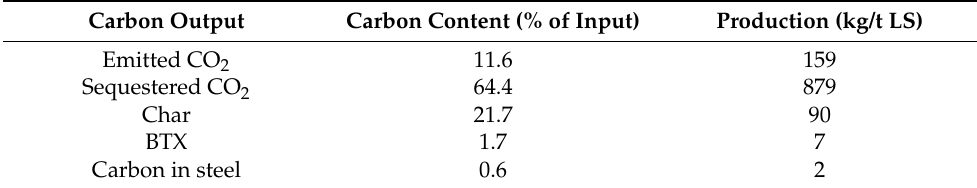
Table 8. Distribution of carbon in the outputs of the process, in terms of the fraction of the total carbon input, which accounts for the carbon in the biomass, the scrubbing agent (RME in the calcu- lations), and the CO 2 from the flux agent, which is assumed to be CaCO 3 in the calculations. The production yields of the outputs are also shown in kg/t liquid steel.